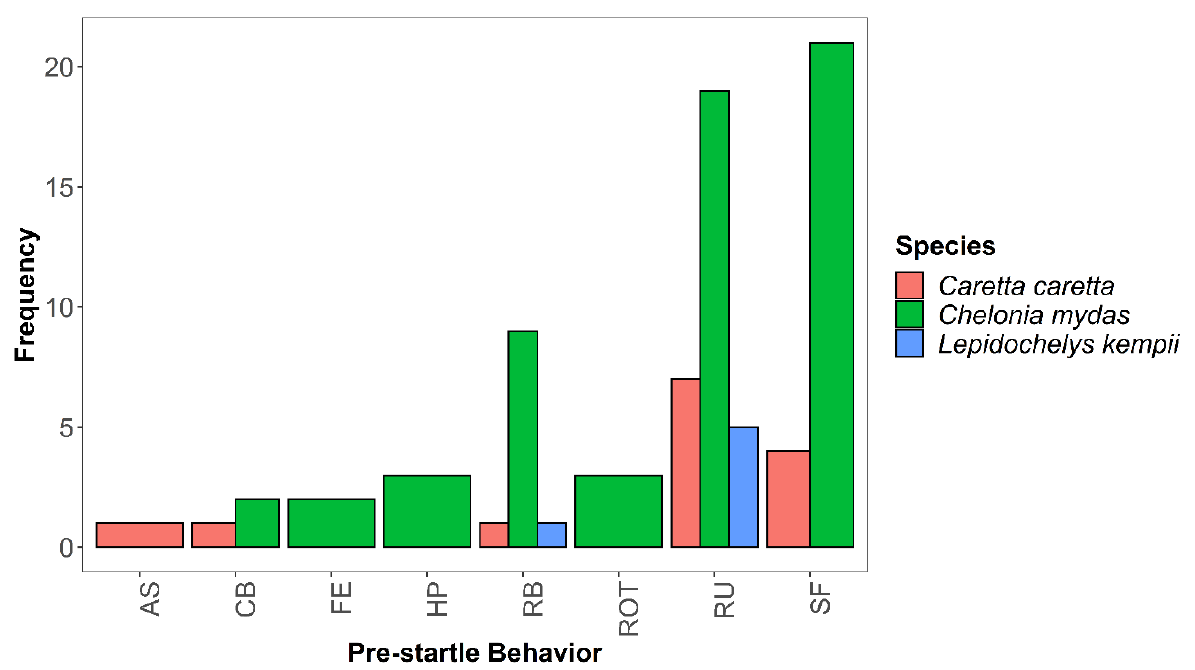
Figure 3. Frequency of pre-startle behavior across three sea turtle species ( Caretta caretta, Chelonia mydas, and Lepidochelys kempii ). Abbreviations: AS–ascent swimming, CB–crawling on benthos, FE–feeding, HP–holding position (no moving), RB–resting on benthos, ROT–resting on top of reef module/substrate, RU–resting under reef structure, SF–swimming forward. Turtles that did not exhibit a startle response are not represented here.